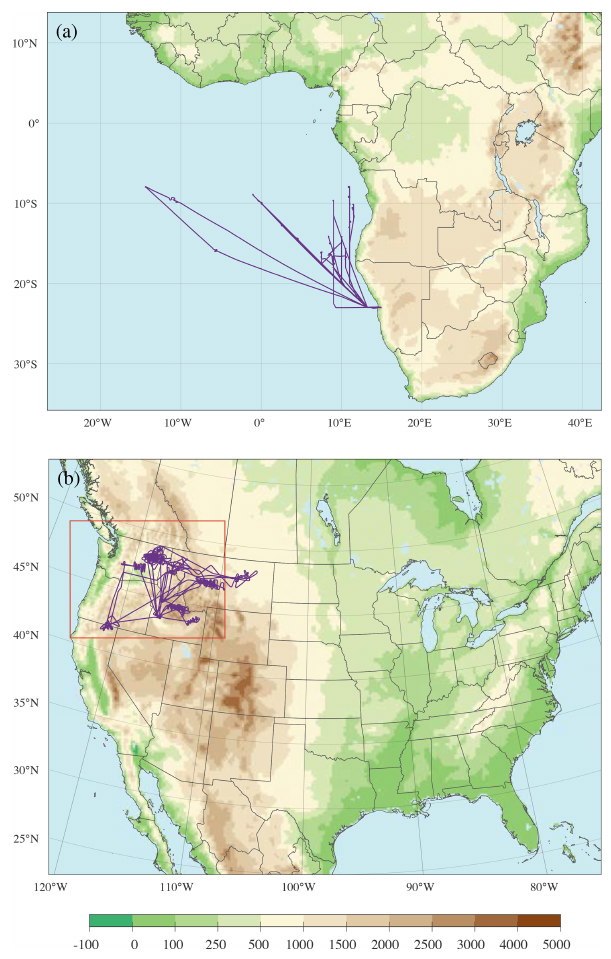
Figure 4. Domains of the simulations conducted in this study using WRF-Chem and VFEI (WRF-VFEI) showing topography (ma.s.l.). Purple lines represent the flight tracks from ORACLES- 2016 (Southern Africa) and FIREX-AQ (North America) used to evaluate the model results. The red polygon in (b) shows the inner domain used in this